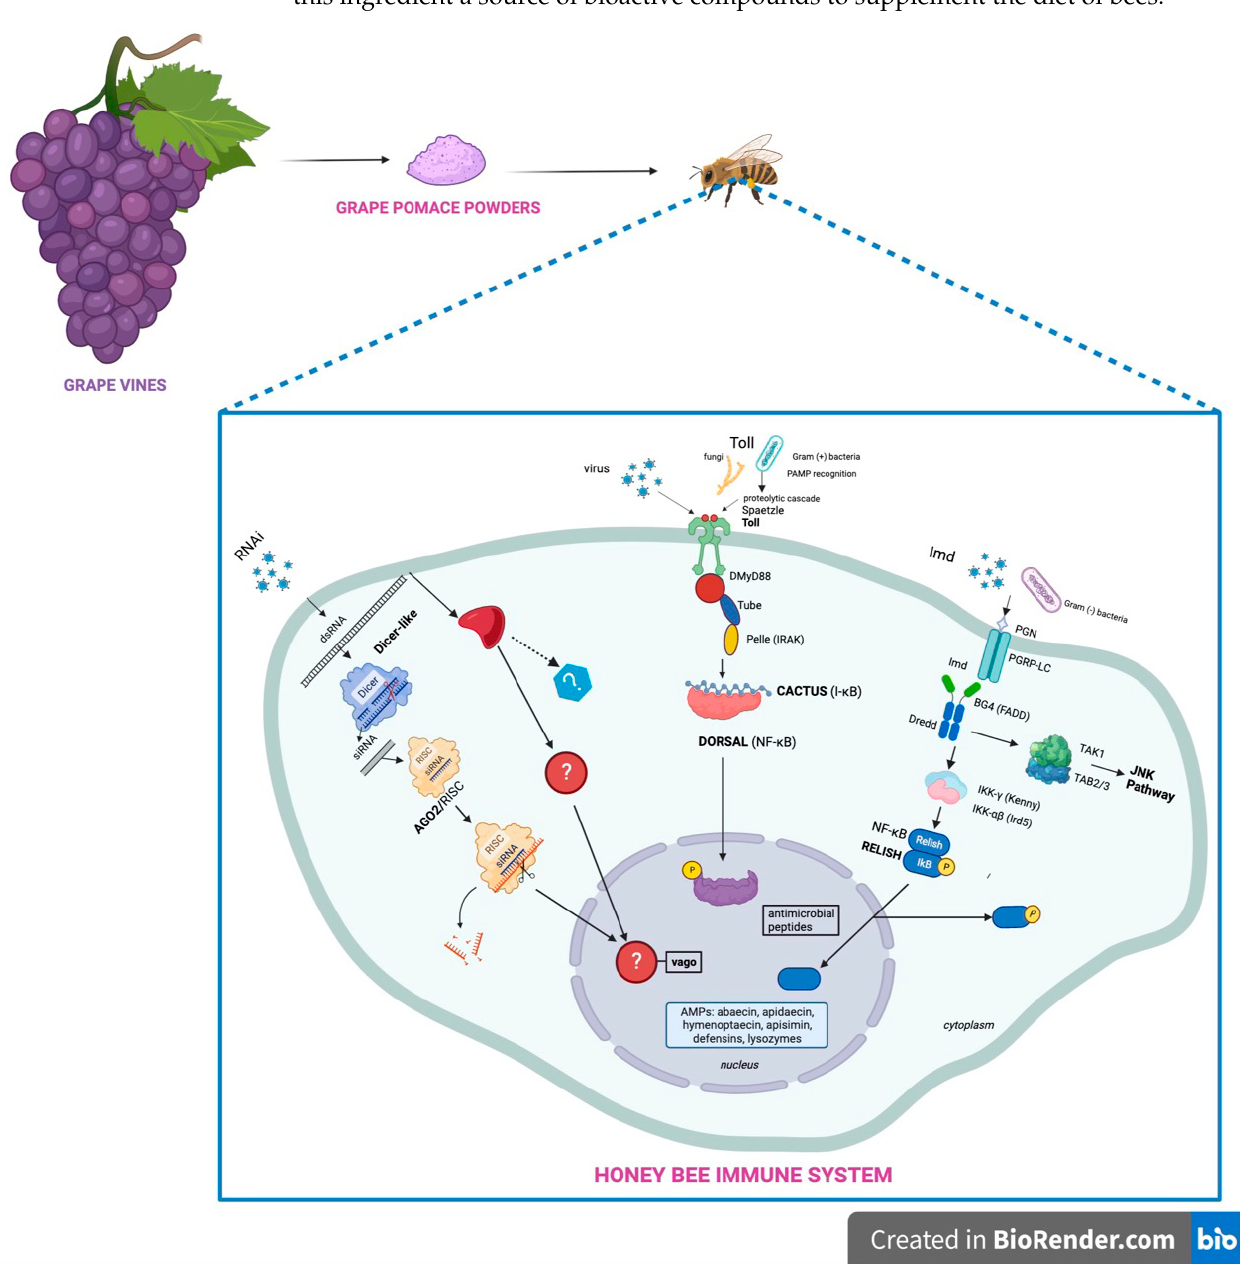
Figure 1. Workflow of the production of GPP as a dietary supplement to strengthen the honeybee immune system.